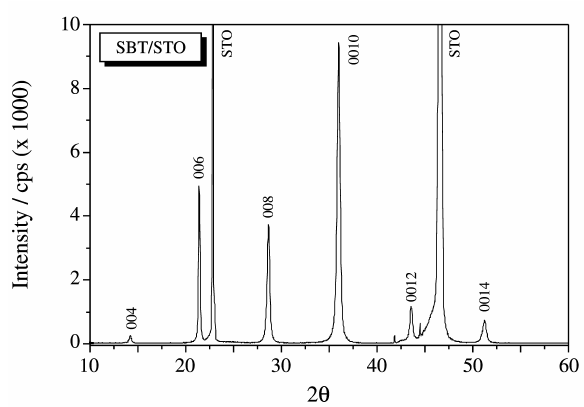
Figure 8. Diffraction pattern of SBT film deposited on STO(100) sub- strate and treated at 800 °C for 2h in an oxygen